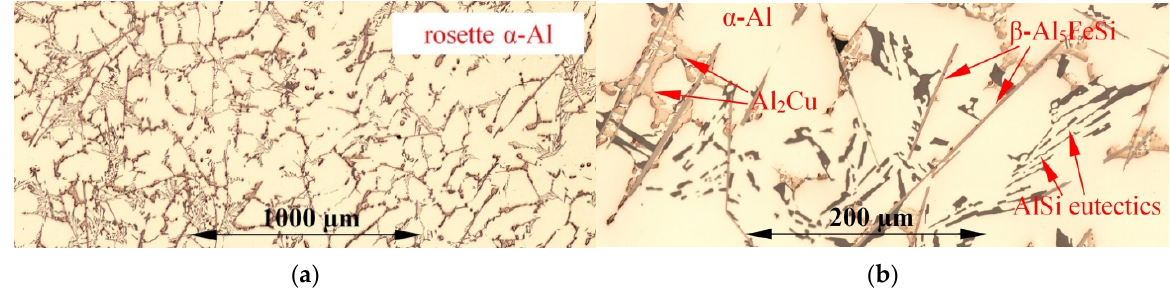
Figure 6. Microstructures of the AlCu4Si6Fe1.0 specimen solidified with electromagnetic stirring. LOM: ( a ) magnification 100 and ( b ) magnification 500×.